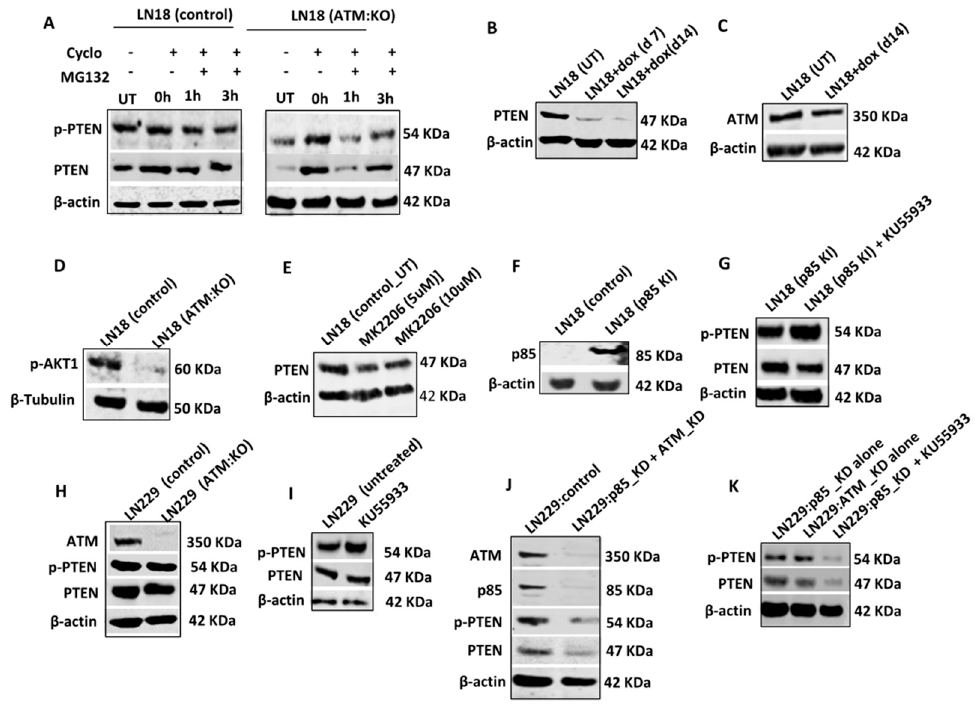
Figure 2. Proteasome mediated PTEN degradation in ATM deficient cells. ( A ) Protein stability assay in LN18 control and ATM KO cells. ( B ) Levels of PTEN and p-PTEN and p85 α in Hela ATM SilenciX cells. ( C ) Levels of PTEN and p-PTEN in Hela control cells treated with 10 μ M KU55933. ( D ) PTEN and p85 α levels in OVCAR3 and OVCAR4 ovarian cell lines. ( E ) PTEN and p-PTEN levels in ATM depleted OVCAR3 cells. ( F ) PTEN and p-PTEN levels in OVCAR3 were treated with 10 μ M of KU55933. ( G ) Generation of doxycycline inducible PTEN knock downs. ( H ) ATM level in PTEN Knock downs. ( I ) p-AKT1 levels in LN18 control and ATM KO cells. ( J ) MK2206 pan AKT inhibitor did not affect PTEN levels in LN18 cells. ( K ) p85 α overexpression in LN18 control cells (LN18 p85 α KI). ( L ) PTEN and p-PTEN levels in LN18 p85 α KI cells treated with 10 μ M of KU55933. ( M ) PTEN and p-PTEN levels in LN229 ATM KO cells. ( N ) Levels of PTEN, P-PTEN in LN229 cells treated with 10 μ M KU55933. ( O ) PTEN and p-PTEN levels in LN229 cells were transfected with p85 SiRNA and ATM SiRNA. ( P ) p85 knock down alone or ATM SiRNA alone did not affect PTEN and p-PTEN levels while p85 knock down and KU55933 leads to PTEN and p-PTEN degradation. ( Q ) PTEN and p-PTEN levels in OVCAR4 cells transfected with ATM SiRNA. ( R ) Levels of PTEN and p-PTEN in OVCAR4 treated with 10 μ M of KU55933. ( S ) OVCAR4 cells were transfected with P85 SiRNA alone or ATM SiRNA alone or P85 and ATM SiRNA simultaneously, or p85 SiRNA and 10 μ M KU55933. Levels of PTEN and p-PTEN were analysed by western blot. All the data are representative of 3 or more independent experiments. Where appropriate, quantification is summarized in Supplementary Figure S2.